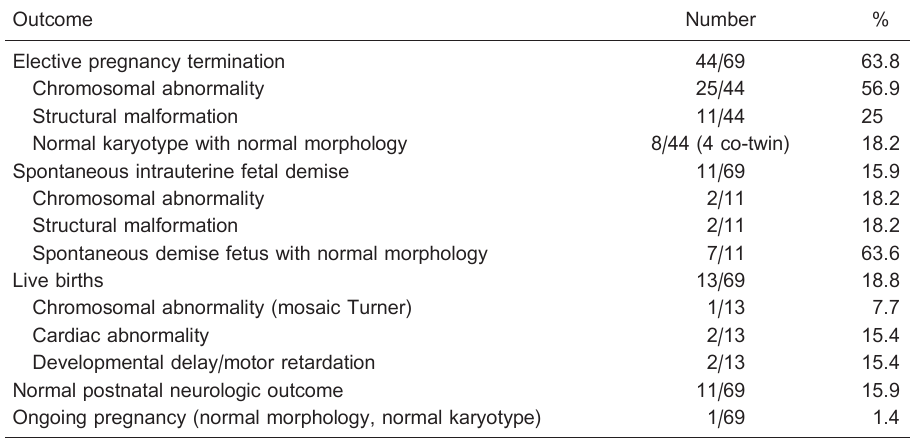
Table 2. Septated cystic hygroma: pregnancy and pediatric outcome